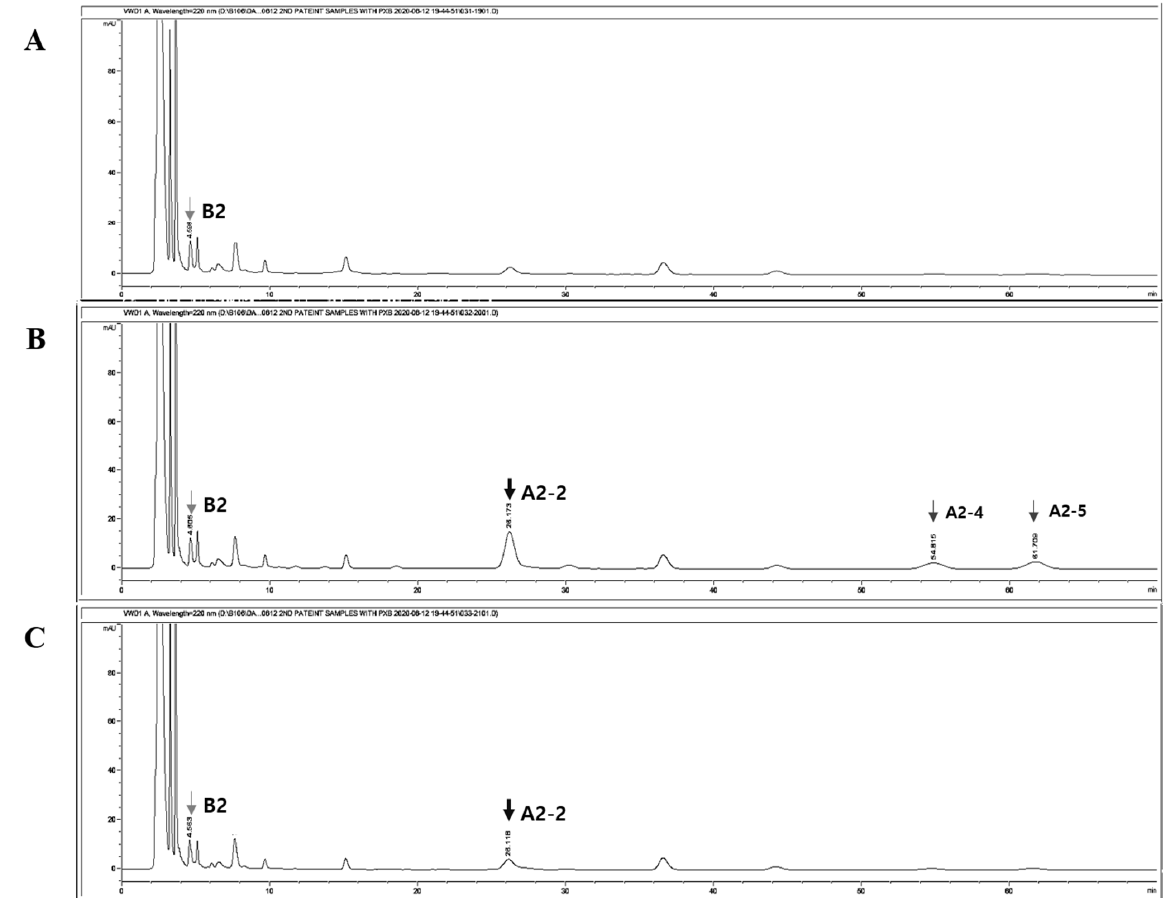
Figure 3. The chromatogram of teicoplanin (Tapocin ® injection) (A2-2) with IS (B2) in a patient’s 3 plasma samples. ( A ) Before teicoplanin administration. ( B ) At 1 h after the administration. ( C ) At 12 h after the administration. Light grey arrow indicated IS. Black bold arrow and dark grey arrows indicate A2-2, A2-4, and A2-5, respectively.